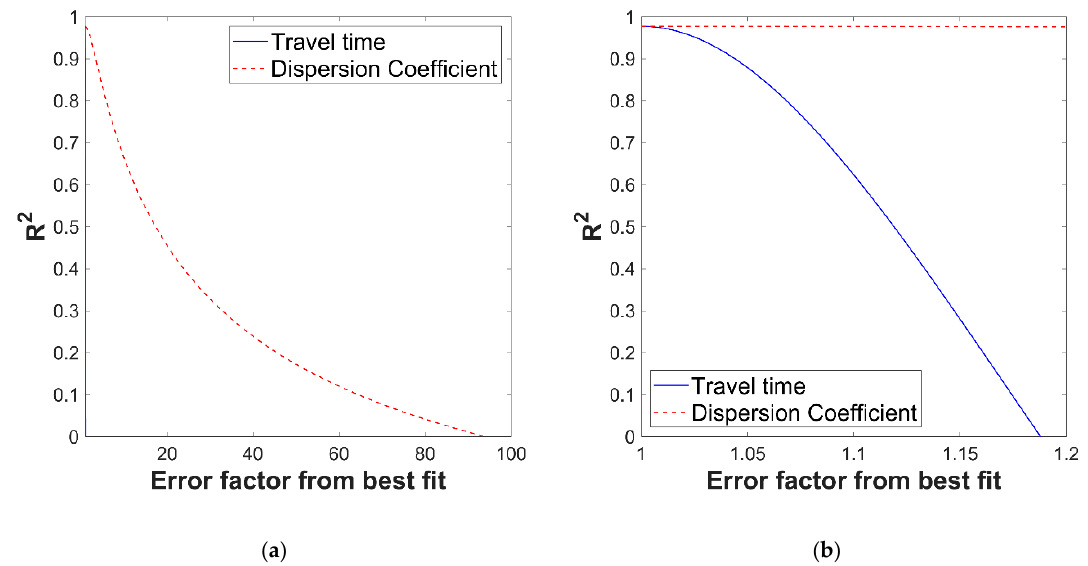
Figure 13. Sensitivity of model to error in travel time and the Longitudinal Dispersion Coefficient. ( a ) Error factor range 1 to 100, ( b ) Error factor range 1 to 1.2.